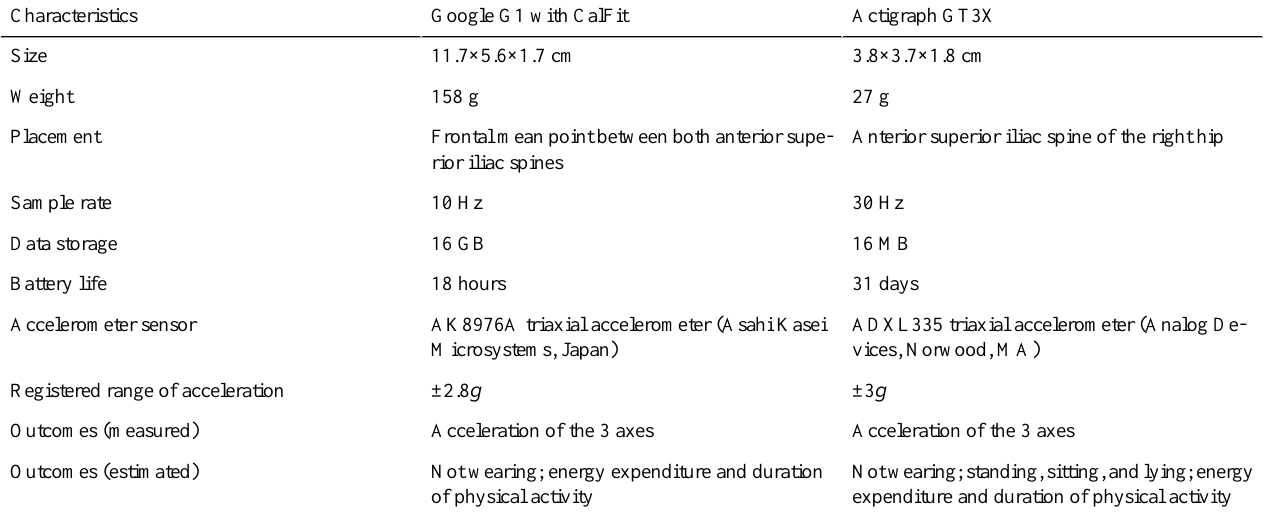
Table 1. Characteristics of CalFit and Actigraph GT3X.